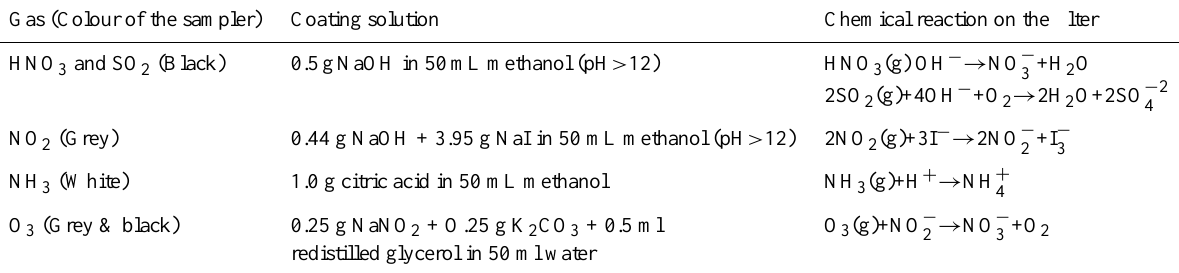
Table 3. Coating solutions and chemical reactions of the HNO 3 , SO 2 , NO 2 , NH 3 , O 3 IDAF passive samplers (WMO TD No: 829; Al- Ourabi,